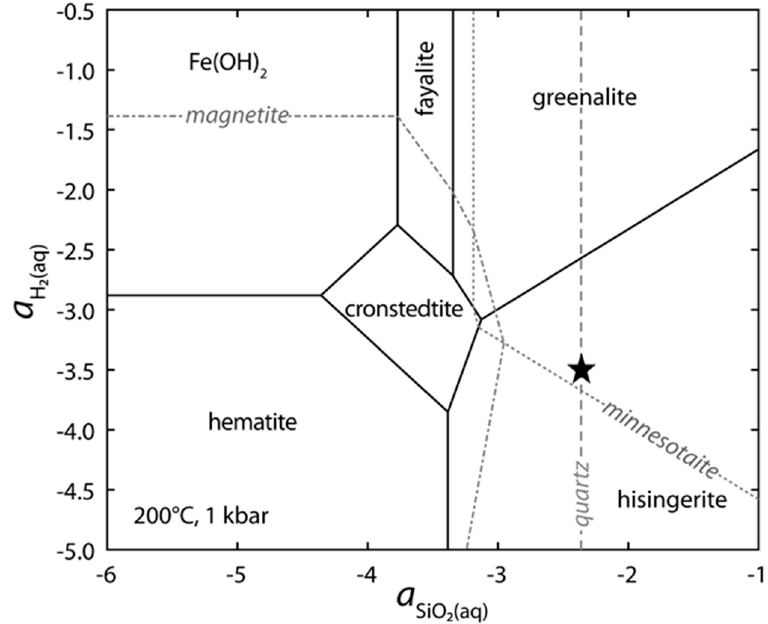
Figure 5. Stability fields of Fe-Si-O-H (FSOH)-system phyllosilicates in terms of the activities of aqueous H 2 ( a H ) and SiO2 ( 𝑎 ) at 200 °C and 1 kbar. The stability bounds for magnetite and minnesotaite, as well as the solubility of quartz, are plotted as dashed lines. The black star represents the fayalite–magnetite–quartz (FMQ) buffer.